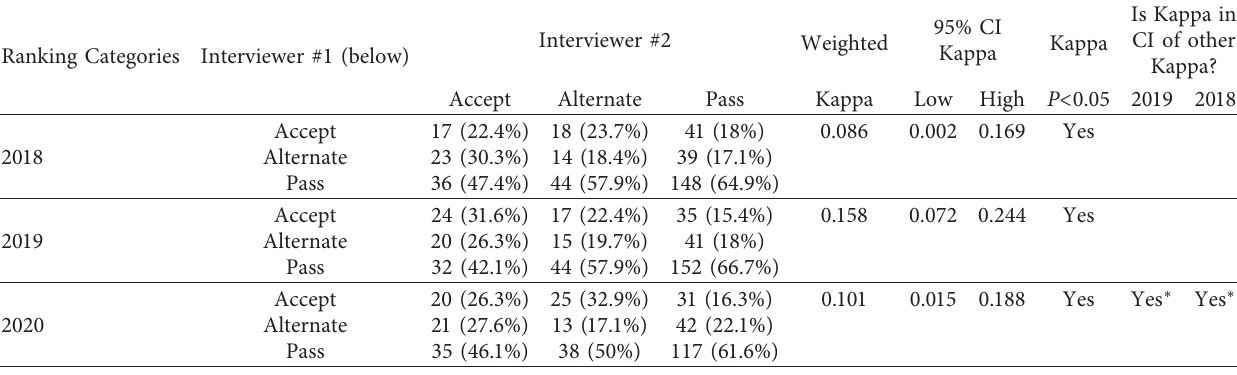
Table 4: Agreement of candidate categories between pairs of interviewers between in-person interviews (2018 and 2019) and virtual interviews (2020).